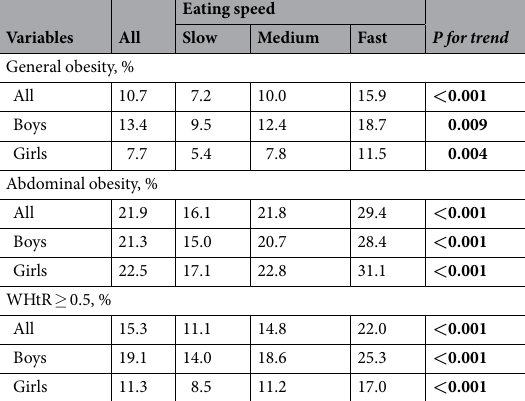
Table 2. The prevalence of obesity and abdominal obesity according to eating speed by gender. All values are presented as percentage. * Differences of obesity, abdominal obesity and WHtR ≥ 0.5 between eating speed groups stratified by gender were evaluated by using Chi-Square tests for trend.